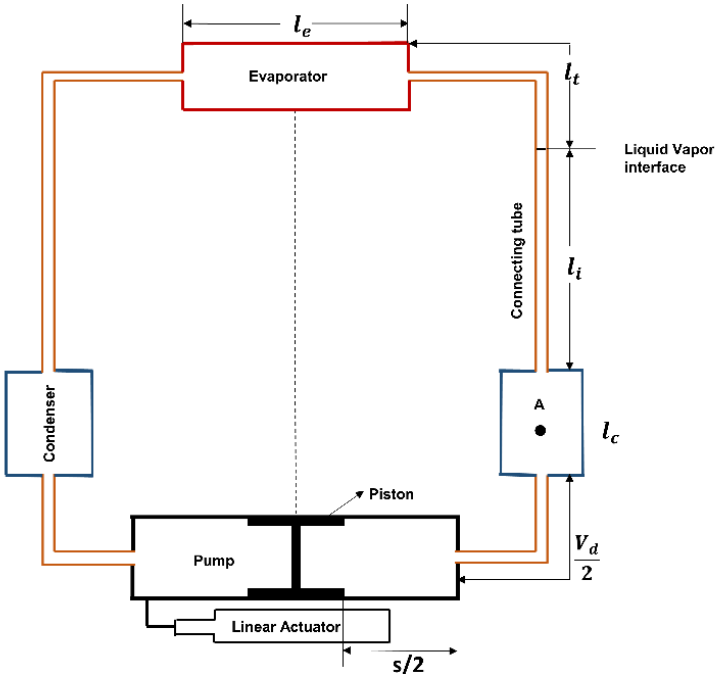
9 of 13 Figure 7. Comparison between the correlation and experiment data. 4. Critical Displacement Volume of the RMDHL